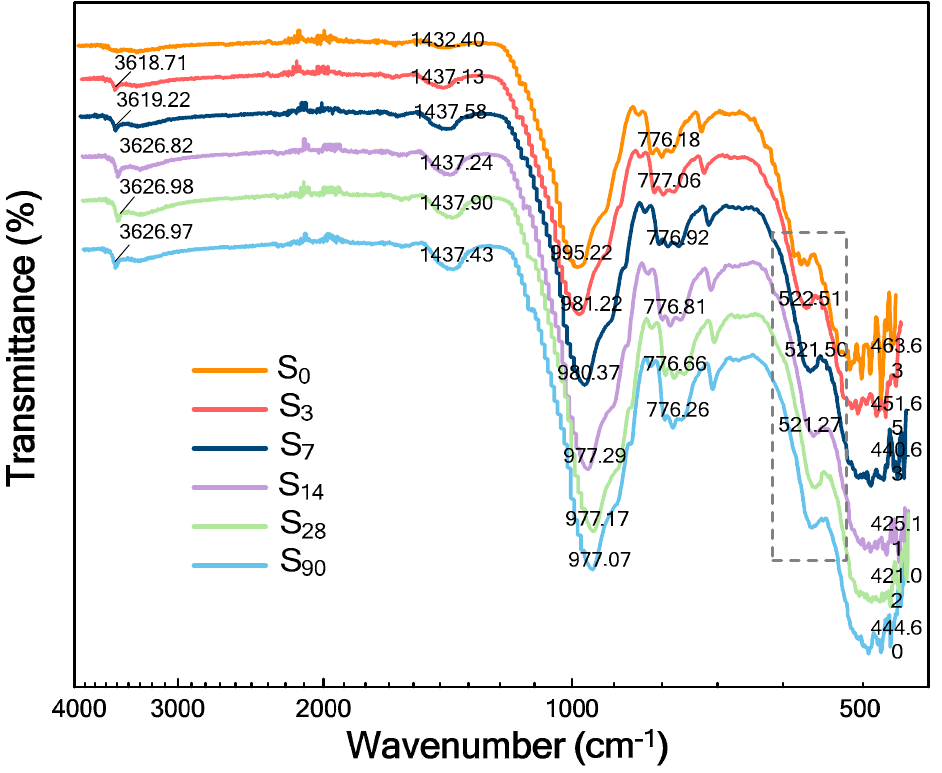
Figure 10. FTIR spectra of waste − based binder solidified/stabilized gold tailings hydrated for six different durations (0 to 90 d).